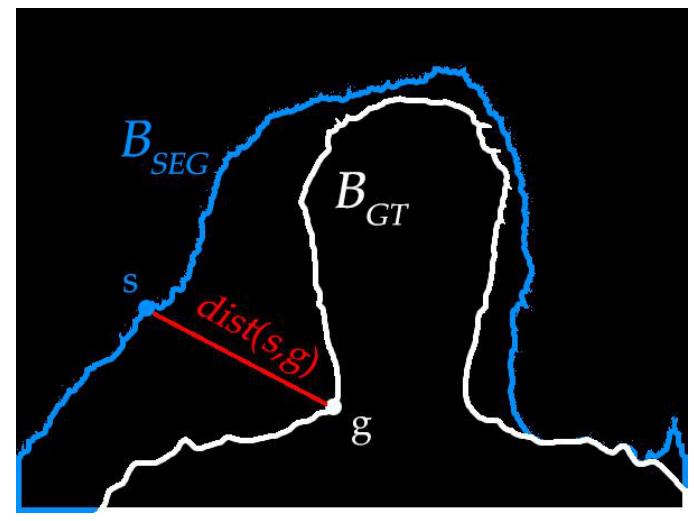
Figure 10. Boundary extraction.